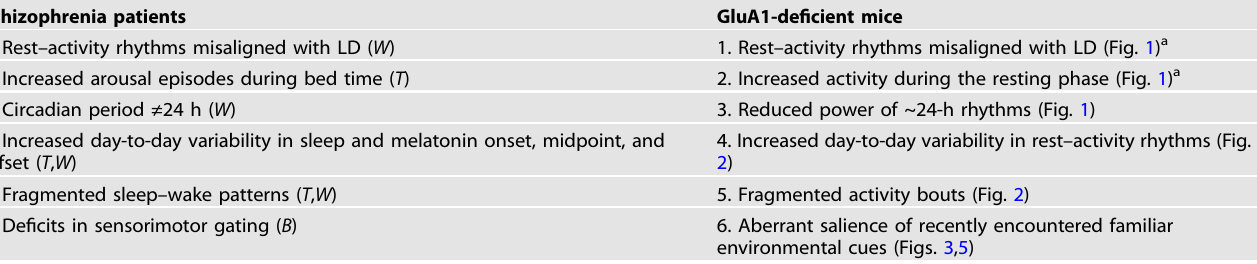
Table 3. Circadian and behavioural abnormalities in schizophrenia and GluA1